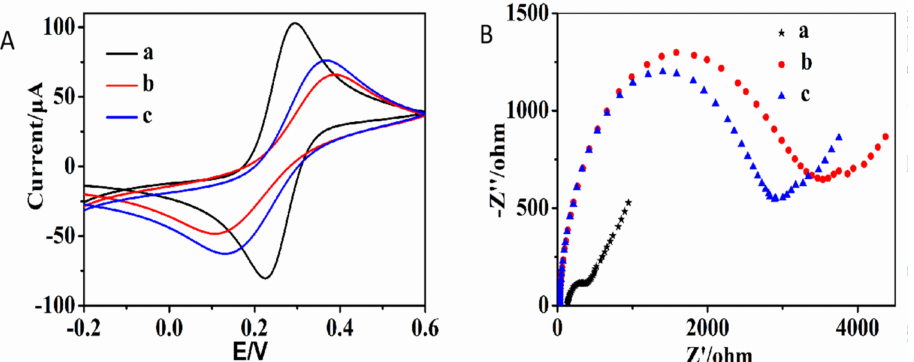
Figure 1. CV curves ( A ) and EIS ( B ) of stepwise modification at Au electrode (a. bare GE; b. GE modified with the P5; c. after being used for detecting